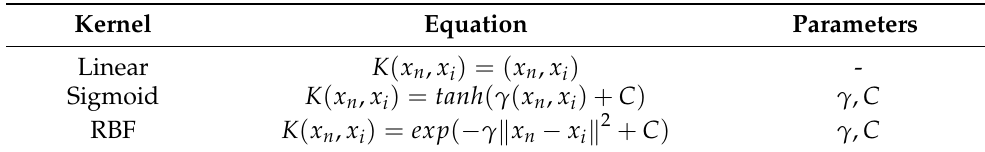
Table 2. Kernel types and their required